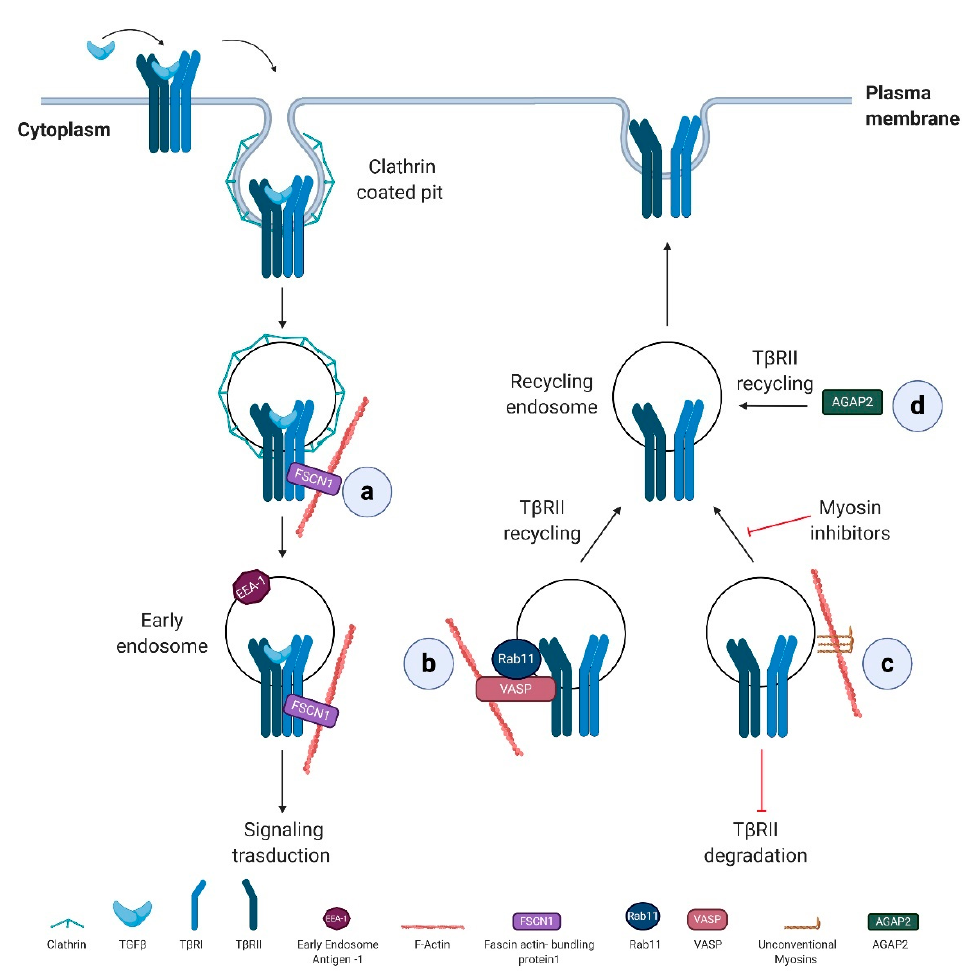
Figure 2. Actin regulatory proteins controlling TGF β type I receptors (T β RI) and II trafficking. ( a ) The internalized T β RI into clathrin-coated vesicles is linked to the actin cytoskeleton via fascin actin-bundling protein 1 (FSCN1) which promotes the trafficking of internalized receptors from clathrin-coated vesicles to early endosomes and thus TGF β signaling. ( b ) VASP promotes TGF β activity by sustaining the complex between Rab11 and T β RII that favors T β RII recycling to the plasma membrane. ( c ) Myosins sustain TGF β signaling by sustaining the cell-surface expression of T β RII receptor and inhibiting its degradation. ( d ) Arf GAP with GTP-binding protein-like domain, Ankyrin repeat, and PH domain 2 isoform 2 (AGAP2) sustains TGF β signaling, by directly or indirectly interacting with T β RII and sustaining the recycling of the receptor to the plasma mem- brane.